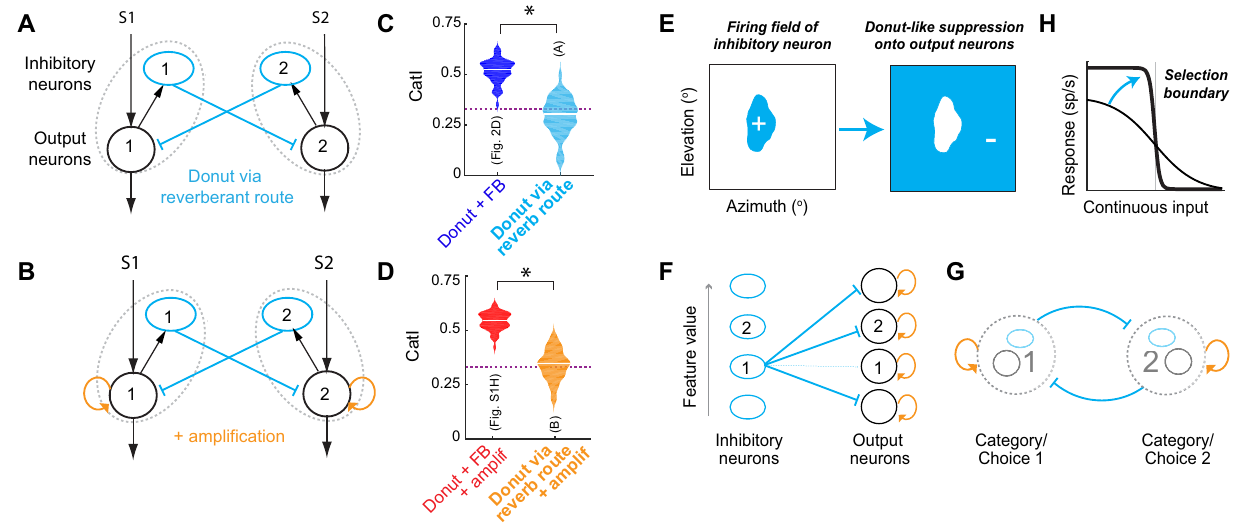
Fig. 7 Alternate implementation (and generality) of the donut-like inhibitory motif. A , B Circuit with implementation of donut-like motif purely via a reverberant route, i.e., in the absence of any feedforward inhibition. A Without recurrent ampli fi cation. B With recurrent ampli fi cation; curved orange arrow. Blue ovals: inhibitory neurons, black circles: excitatory/output neurons, dashed gray ovals: populations of neurons representing each stimulus or category. C , D Plots of CatI computed from the responses of output neuron 1 in circuits in ( A ) ( C , fi lled light blue data) and in ( B ) ( D , fi lled orange data), to the standard two-stimulus morphing protocol (as in Fig. 2B). For comparison, the CatI values for the corresponding models with feedforward implementation of the donut-like motif are reproduced here (in C : dark blue data from Fig. 2D; in D : red data from Fig. SH). * p < 0.05. Filled light blue vs. dark blue, p = 1.7e-25; orange vs. red, p = 2.5e-31; paired two-sided t tests with HBMC correction. Purple dashed line: CatI of purple model from Fig. 2A, which has just the feedforward donut-like motif sans feedback; reproduced here from Fig. 2D. n = 50 model neurons; center lines in the violin plots indicate median values. E – H Graphical summary of central fi ndings of this study. E Donut-like inhibition, i.e., inhibition ( − ) driven by preferred inputs ( + ) and delivered to all non-preferred inputs, can be implemented in neural circuits either in a feedforward manner ( F ) or in a reverberant manner ( G ), to generate categorical selection boundaries ( H ). F , G Blue ovals: inhibitory neurons, black circles: excitatory/output neurons. F dashed thin blue arrow indicates absence of inhibitory projection. G based on Figs. 1 – 4; ( G ) is a simpli fi ed representation of model in ( B ), in which populations of neurons representing each category or choice (dashed gray circle) mutually inhibit one another. The similarity of this reduced model structure to several previous models of selection highlights the generality of our fi ndings and provides a mechanistic explanation for the ability of those models to produce categorical selection boundaries 40, 64, 67, 68 ; see text. H Ability of donut-like motif to convert linear response pro fi les (thin black) to categorical (thick black) ones. Source data are provided as a Source Data fi